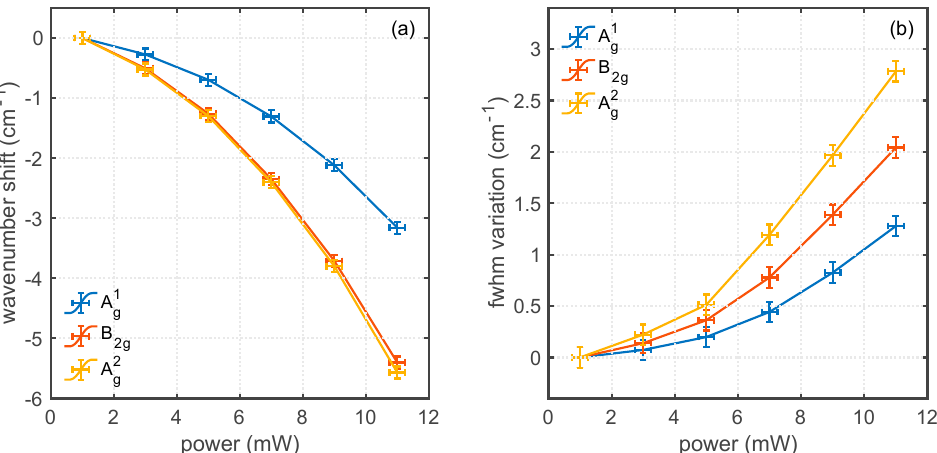
Figure 3. Modification of the three main Raman bands of black phosphorus on gold as a function of the illumination power. ( a ) Relative decrease in central wavenumber Δω . ( b ) Variation of the full width at half-maximum ΔΓ .